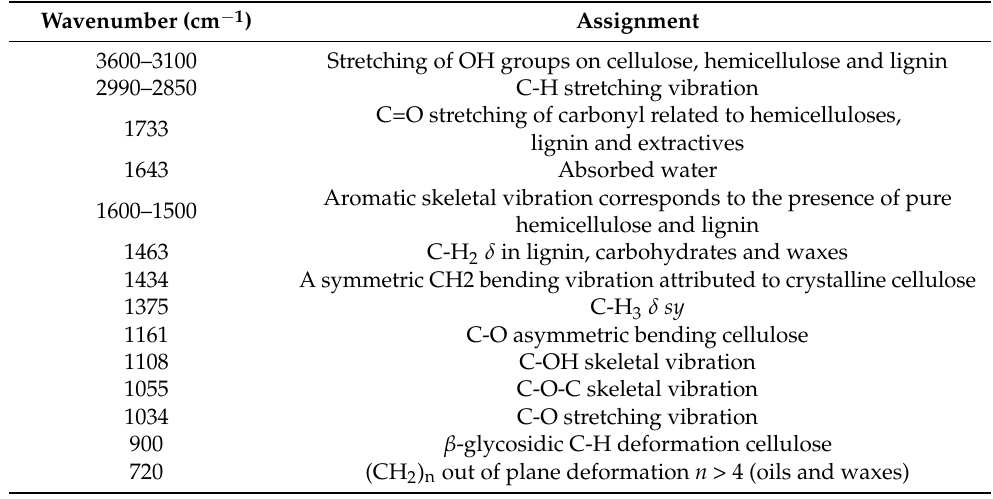
Table 1. Infrared bands assignments for cellulose, hemicellulose and lignin [31–33].